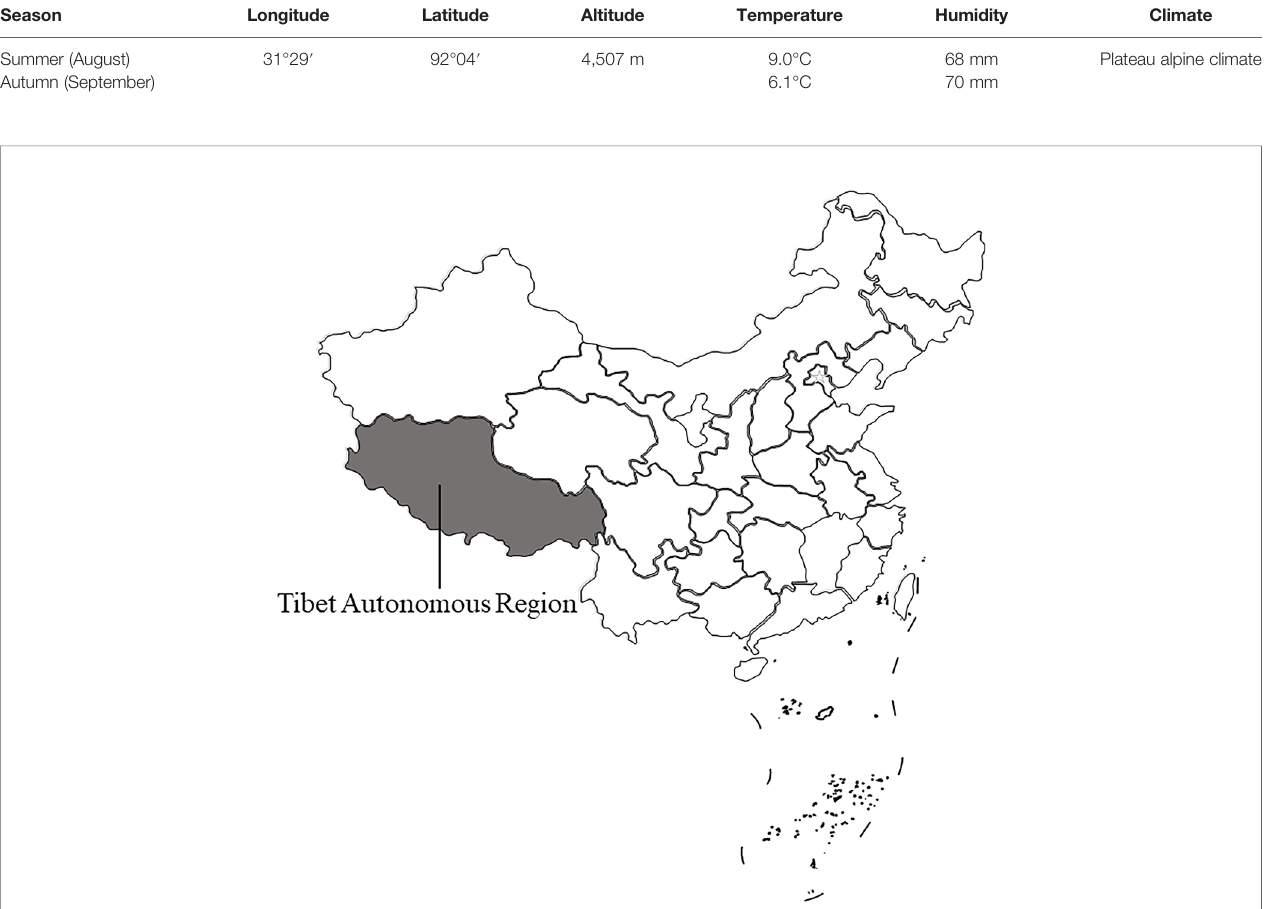
FIGURE 1 | A map of Tibet Autonomous Region, China, in which Tibetan antelope are